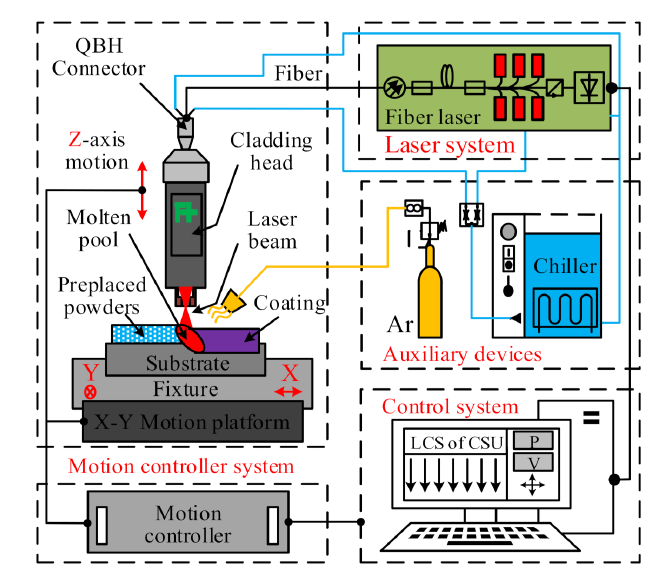
Figure 1. Schematic diagram of laser cladding set-up.